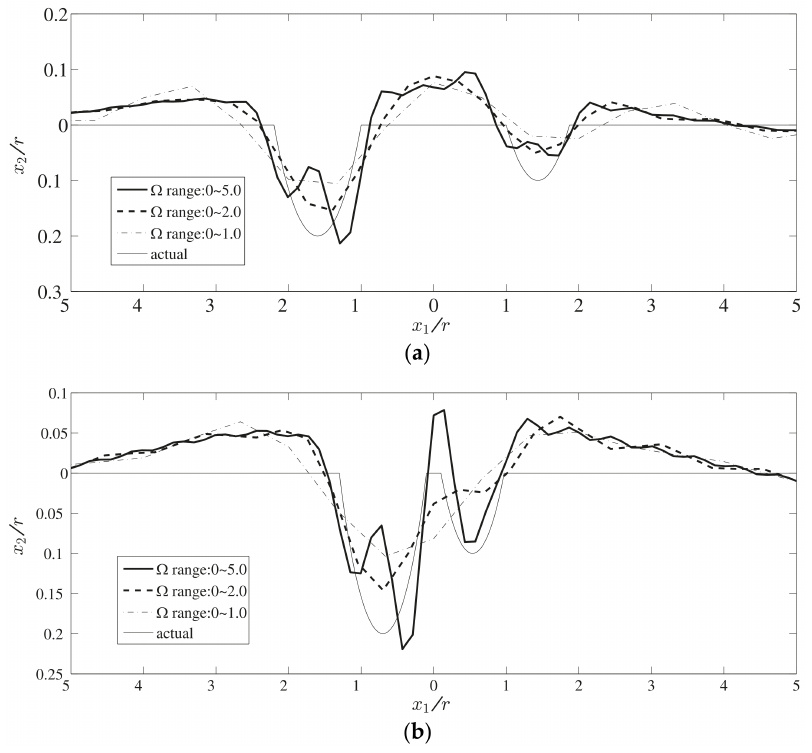
Figure 11. Inverse reconstruction results of double-canyon flaws ( a ) l / r = 2.0; ( b ) l / r =